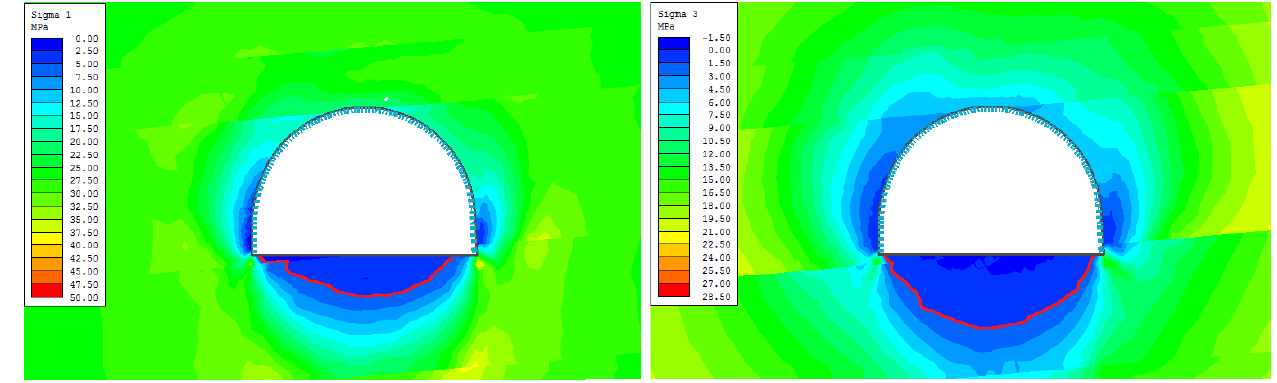
Figure 22. Extent of the failure zone beneath the waterlogged floor of roadway D-2 — stage 2. In the third stage, the geomechanical parameters within the previously delineated failure zones were further reduced. In this stage, these parameters for the first-stage failure zone were assumed to be as they were after six hours of soaking with water, whereas, for the second-stage failure zone, they were assumed to be as they were after three hours of soaking. Subsequently, the model produced the maps of the normal stress distributions and the failure zone, which reached 160 cm down from the roadway floor (Figure 23).